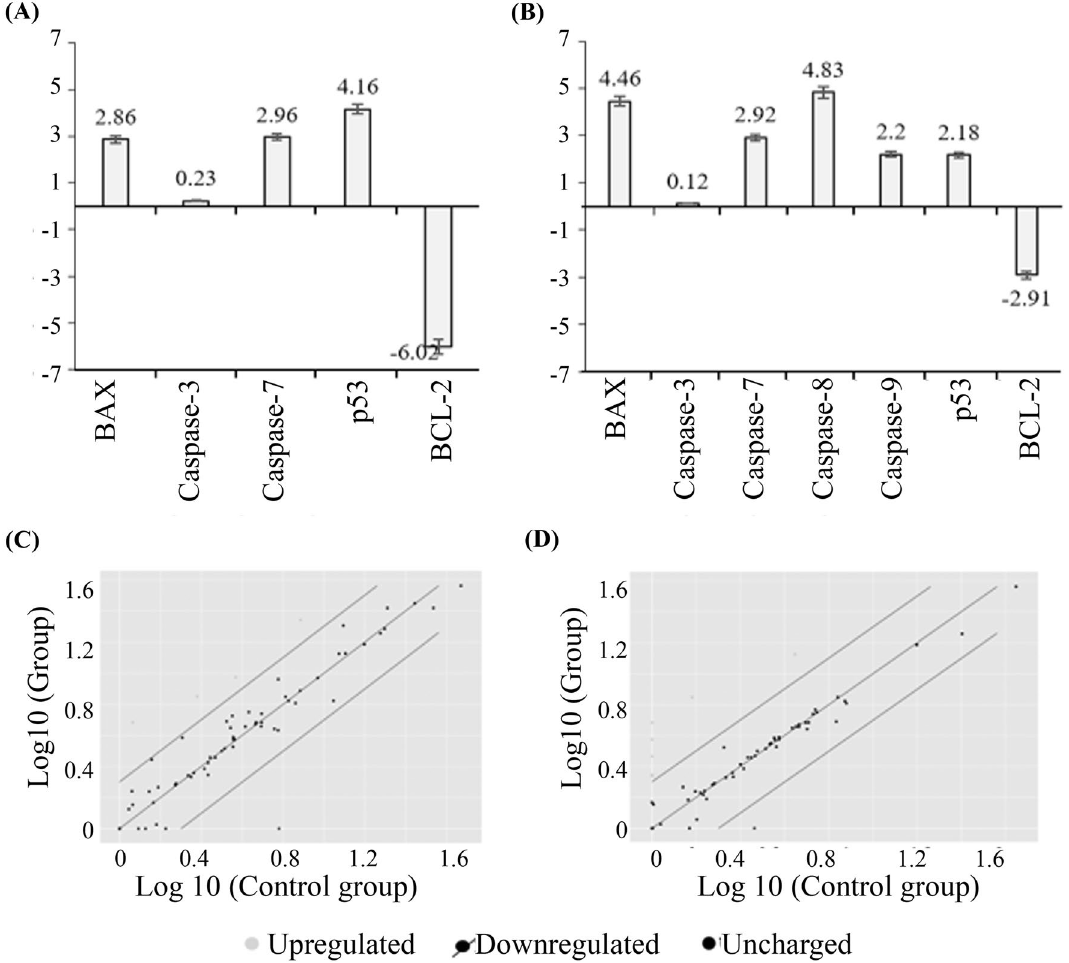
Figure 12. RT 2 Profiler PCR Array (PAHS-012ZA) for MCF7 cell lines. ( A ) the fold change values for cancer cells treated with the AtMP1, ( B ) fold change values for cancer cells treated with the AtMP2. ( C ) The Scatter Plot compares every gene’s normalized expression on the PCR Array for cancer cells treated with the AtMP1, ( D ) the Scatter Plot compares the normalized expression of every gene on the PCR Array for cancer cells treated with the AtMP2. The results analysis by using Gene Globe Data Analysis Centre. Genes showed less than 1.5- fold change were neglected. The full list of genes was mentioned in supplementary figures file (Supplementary Tables S3,